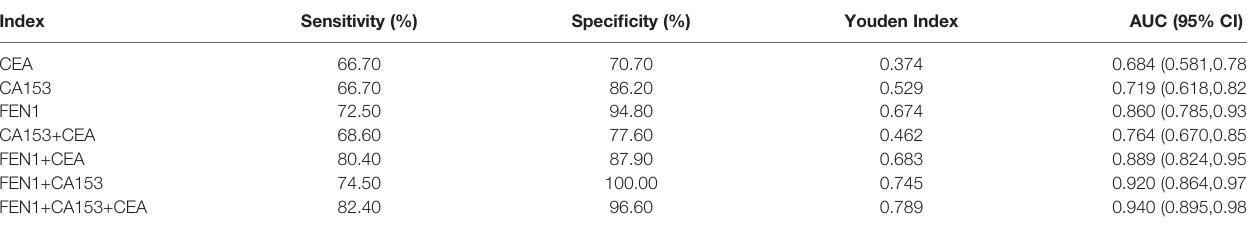
TABLE 1 | The diagnostic performances of FEN1, CA153, and CEA in distinguishing BC from the healthy and benign groups.